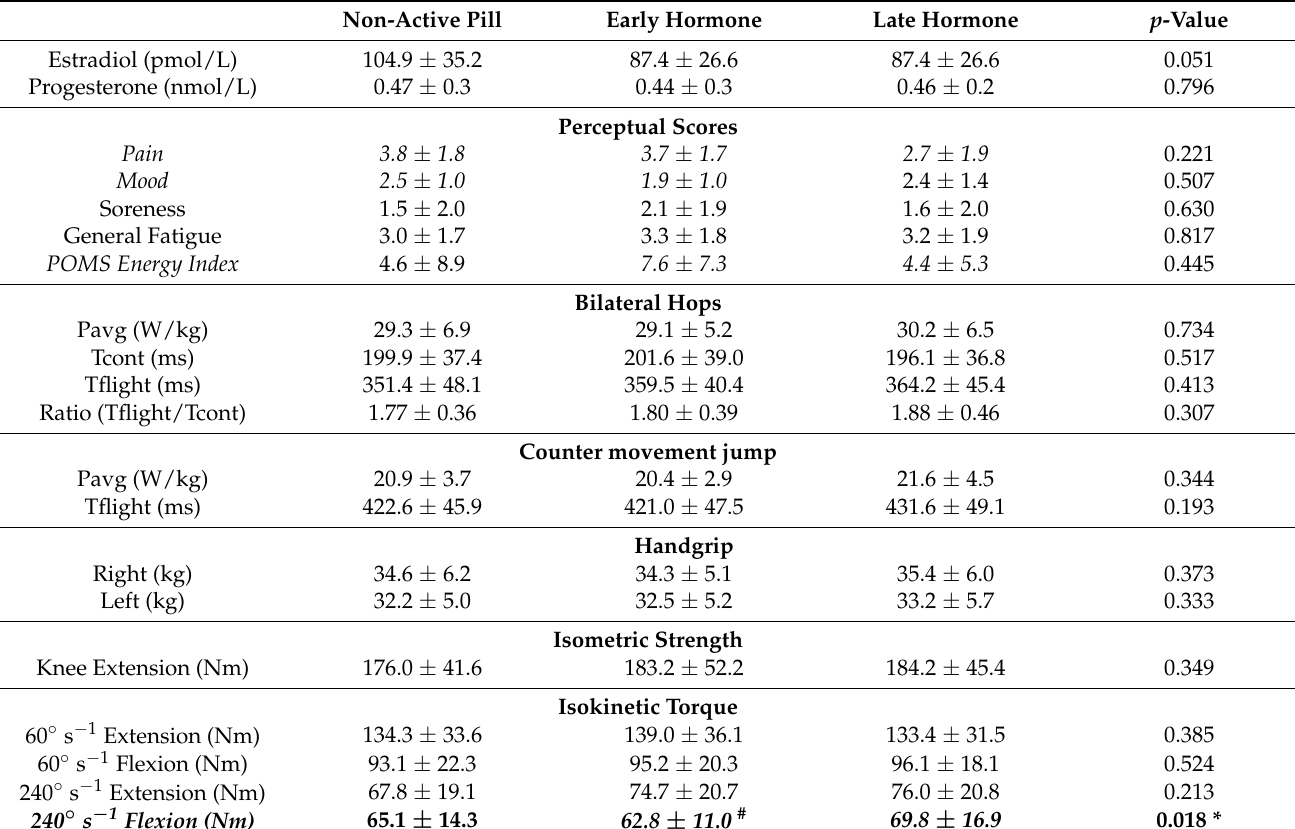
Table 2. Hormone concentrations, perceptual and muscle function measures for the high-androgenicity Oral Contraceptive group ( n = 10) over the three phases of the oral contraceptive